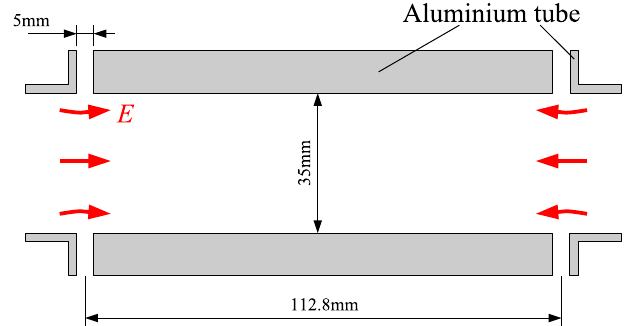
FIG. 4. Schematic drawing of the double-gap drift-tube cavity for SBRC experiments at S-LSR. The cavity is designed to bunch a 40 keV 24 Mg þ beam at the harmonic number of 100. The direction of the rf electric field is reversed in every half rf period.